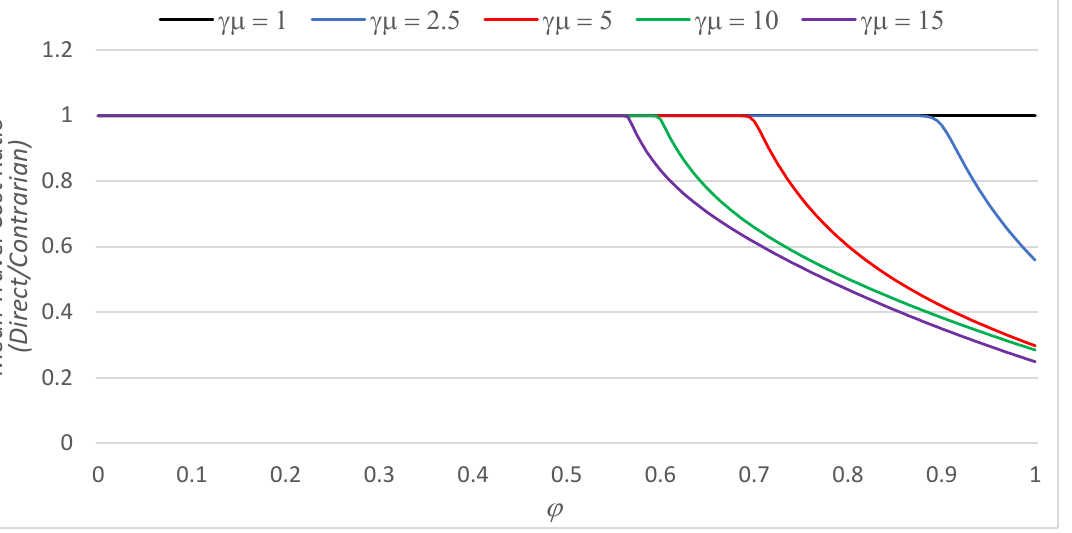
Figure 7. Long-term ratio of direct to contrarian mean travel cost as a function of 𝜑 for 𝛼 = 0.1, 𝛽 = 0.1 and different values of 𝛾𝜇 (case of linear link cost functions).